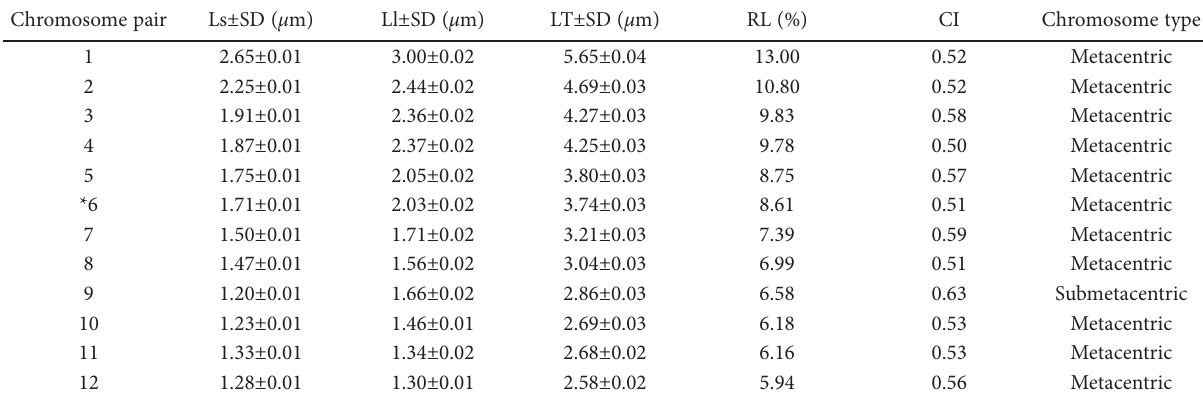
Table 5. Mean length of short arm chromosome (Ls), long arm chromosome (Ll), total arm chromosome (LT), relative length (RL), centro- meric index (CI) and standard deviation (SD) of RL, CI from 20 metaphases of Ar. maxwellii (2 n =24). Chromosome